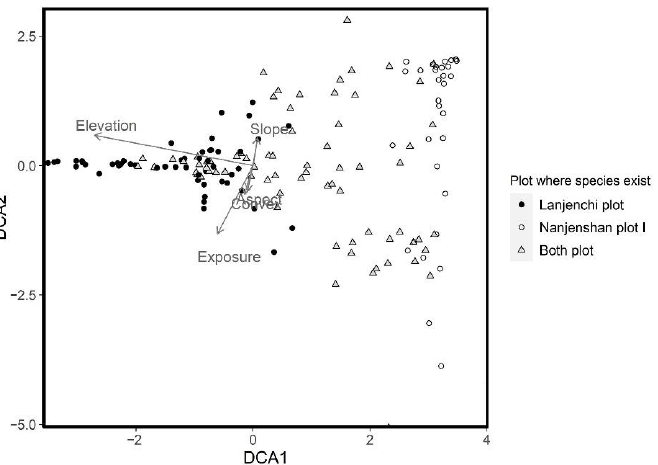
Figure 2. Distribution of 160 species between the first and second DCA axes. Solid circles represent the species that were only distributed in the Lanjenchi plot; hollow circles represent the species only distributed in the Nanjenshan plot I; and grey triangles represent the species found both in the Lanjenchi plot and Nanjenshan plot